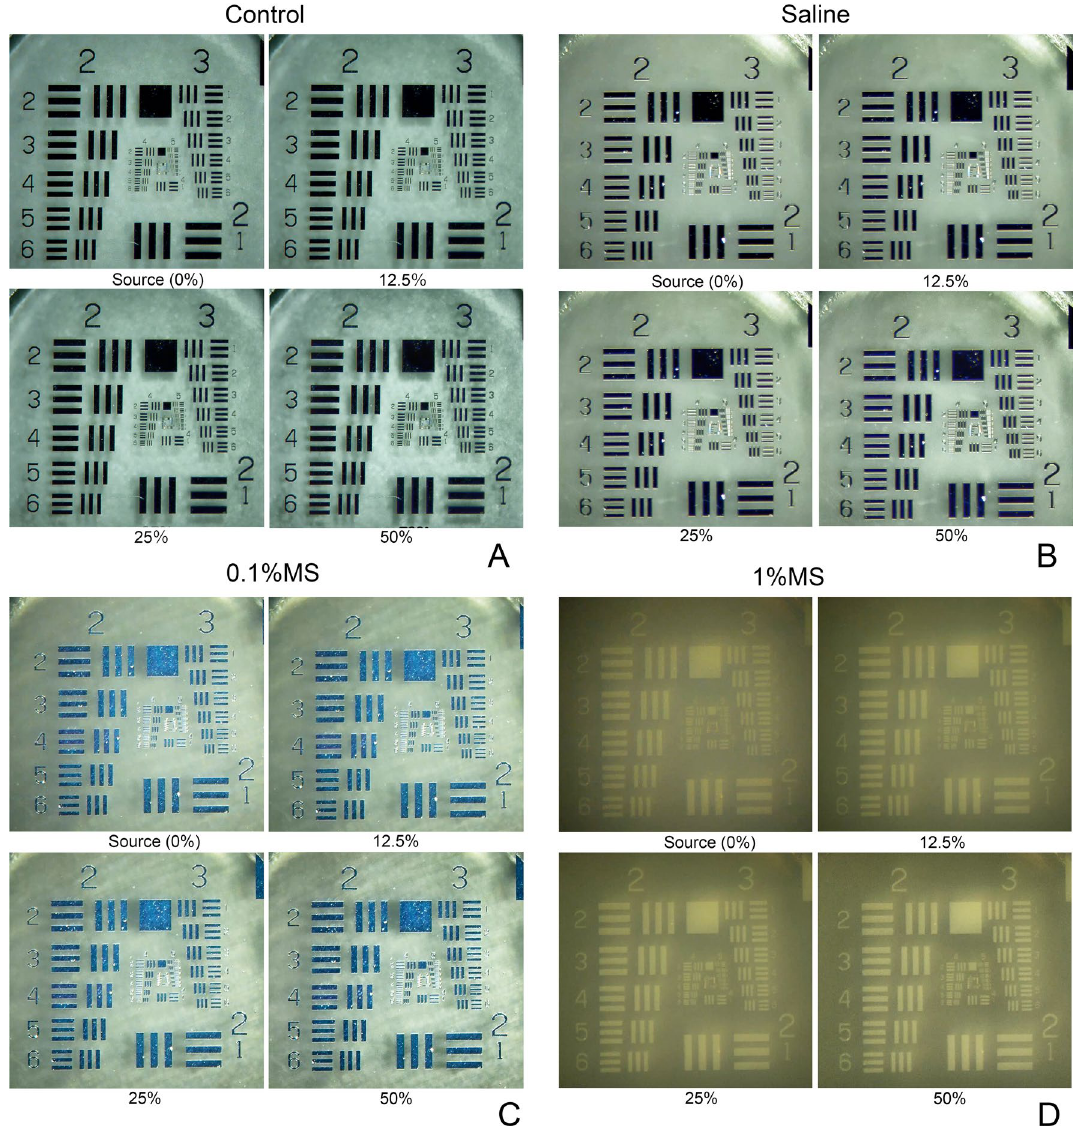
Figure 6. Images of the 1951 United States Air Force (USAF) grating targets through saline and milk solution (MS). ( A ) In the control (no fluid), the grating images are not enhanced when the image-sharpening intensity is increased, but its shadows are enhanced and the white background behind the targets appears brighter. Through the saline solution ( B ), the grating target images are only slightly enhanced even when the image-sharpening intensity is increased, but the enhancement of the shadows of the grating target images seen in the control is reduced. The white background behind the targets appears brighter with an increase in the image-sharpening intensity which was also less than the increase of the control. At 0.1% MS ( C ), the entire index images were bluish-green in color. The grating targets are more contrast-enhanced when the image-sharpening intensity is increased. The shadows of the grating targets and the white background appear more enhanced and the background speckle pattern is emphasized more with increasing image sharpness compared to saline. At 1% MS ( D ), the entire index images appear darker probably because light does not reach it. When the image-sharpening intensity is increased, the target images become brighter and the background darker, and they are observed more clearly due to the increased contrast. As the image-sharpening intensity increases, even fine details of the indices that are blurred can be observed, and the resolution is observed to have improved under the 1% MS condition. For example, the 4–5 and 4–6 indicators are indistinguishable without image-sharpening but becomes clearer as the intensity of image-sharpening is increased to 25% and